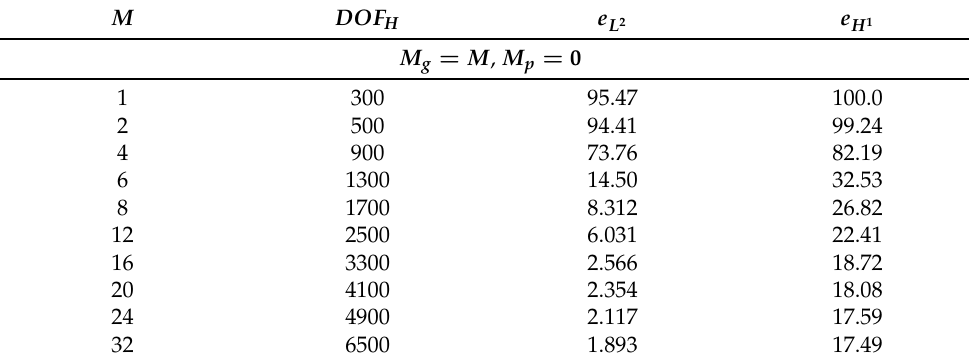
Table 3. Elasticity problem. Case 1 (homogeneous boundary conditions). Relative L 2 and H 1 error in %. DOF h = 170,460.